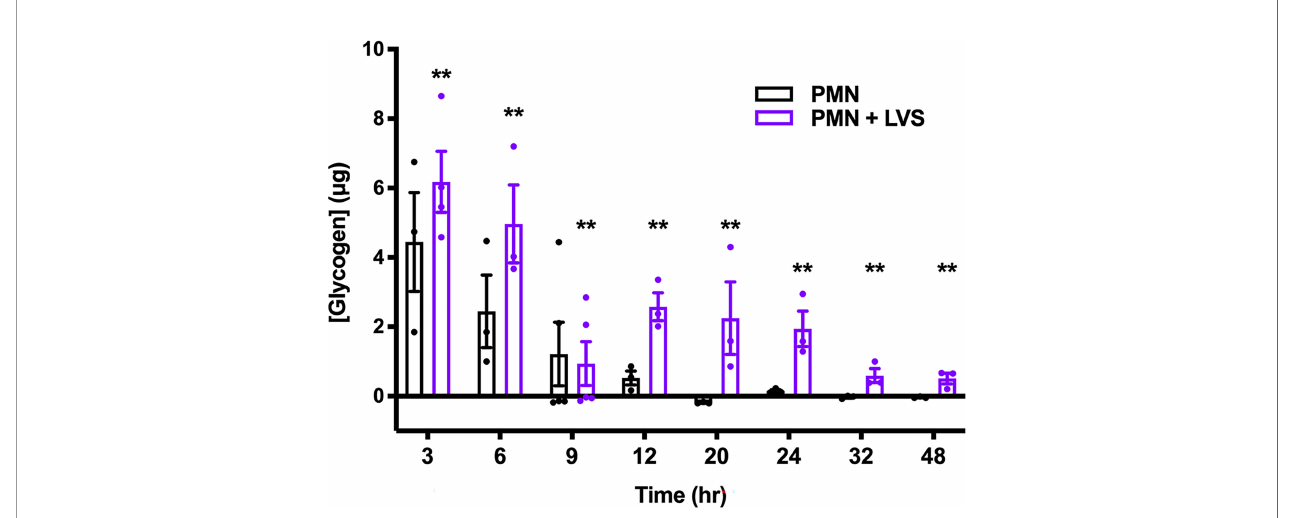
FIGURE 7 | LVS modulates PMN glycogen dynamics and abundance. Glycogen stores of control and LVS-infected PMNs were quanti fi ed at the indicated timepoints, n=3-5. ** p < 0.01 compared to control PMNs at each